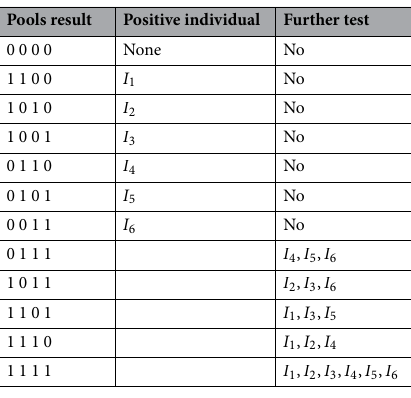
Table 1. Decision rule for P 64 ( 1 = positive pool, 0 = negative